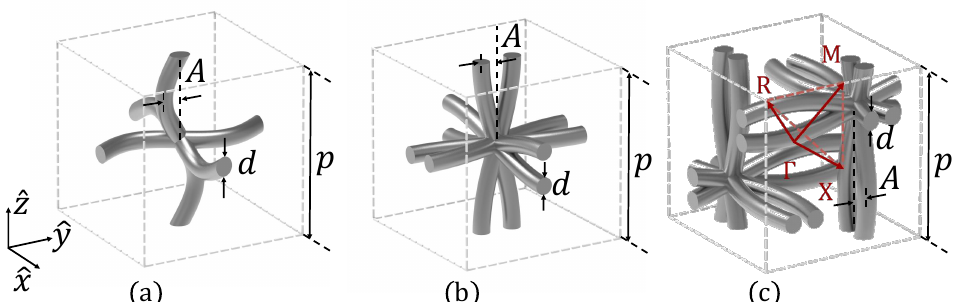
Figure 1. Evolution of double-mesh twin-wire unit cell: ( a ) single-wire unit cell; ( b ) twin-wire unit cell; ( c ) double-mesh twin-wire unit cell. The mean path of the meandered wire is described by S ( ν ) = A sin ( N νπ / p ) ( ν ≡ x , y , z ). p is the period of the unit cell and N stands for the number of turns within one period ( N = 1 in all present schematics).